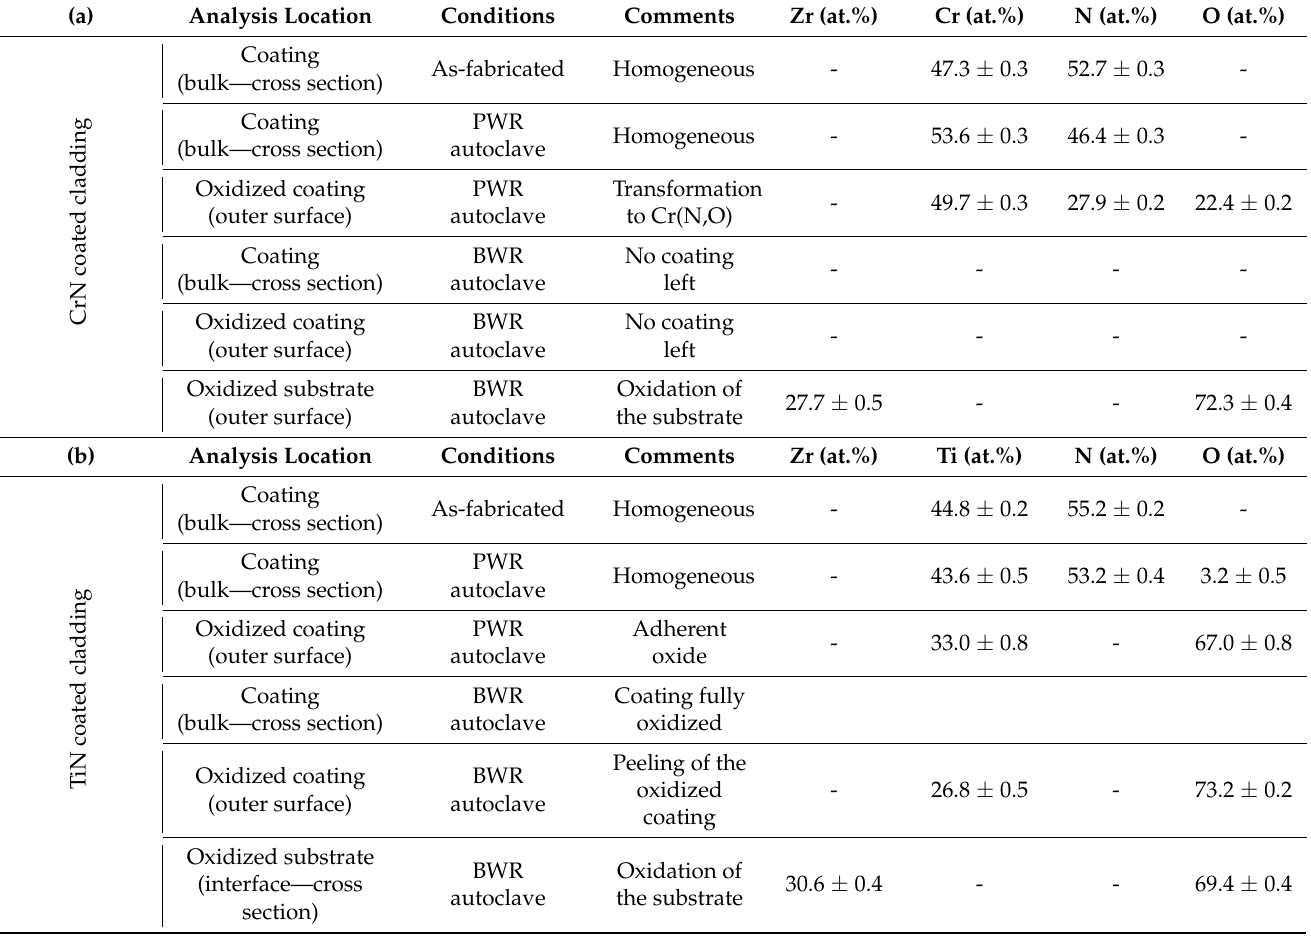
Table 1. Results of EDS point analysis on as-fabricated and autoclave-exposed coated claddings: ( a ) CrN-coated claddings and ( b ) TiN-coated